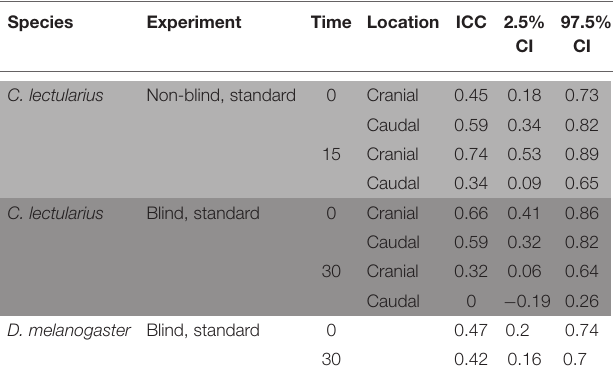
TABLE 4 | Intra-class correlation coefficient (ICC) of sperm viability across four pictures of the same subsample in a non-blind standard count in Cimex lectularius (area highlighted in light gray, n = 14), a blind count Cimex lectularius (area highlighted in dark gray, n = 15), and a blind count in Drosophila melanogaster (white area, n =